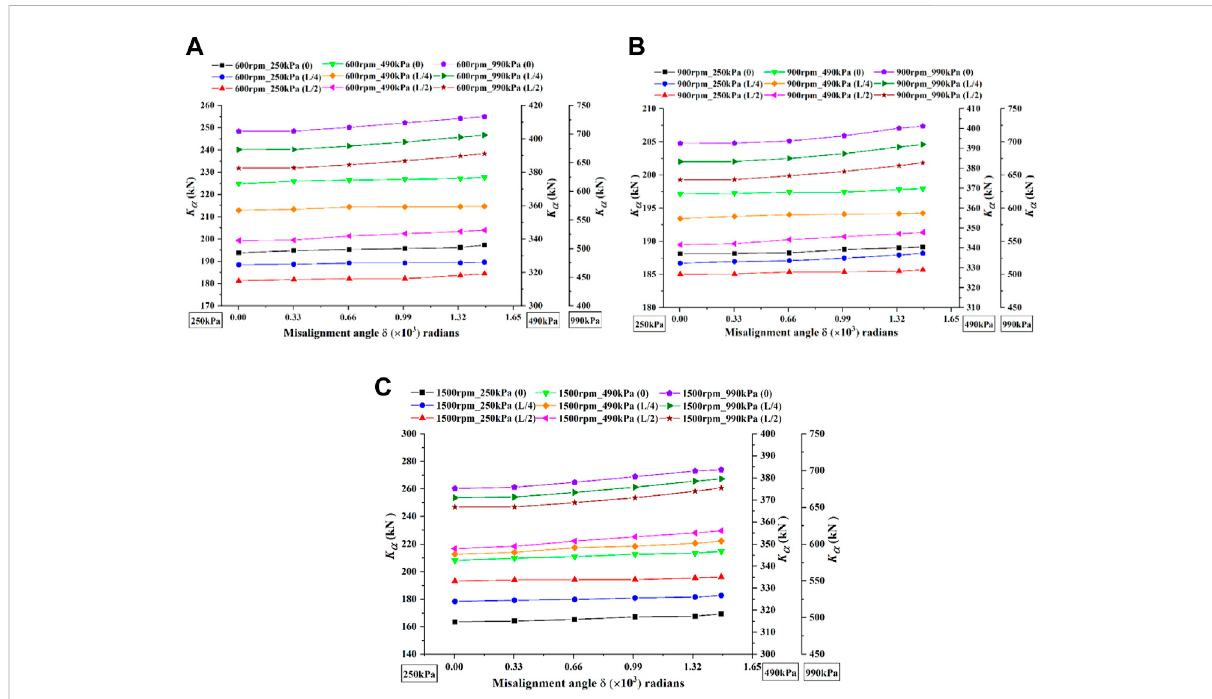
FIGURE 11 The variations of direct stiffness with misalignment angle under different pressure differences and rotational speeds. (A) 600rpm. (B) 900rpm. (C)